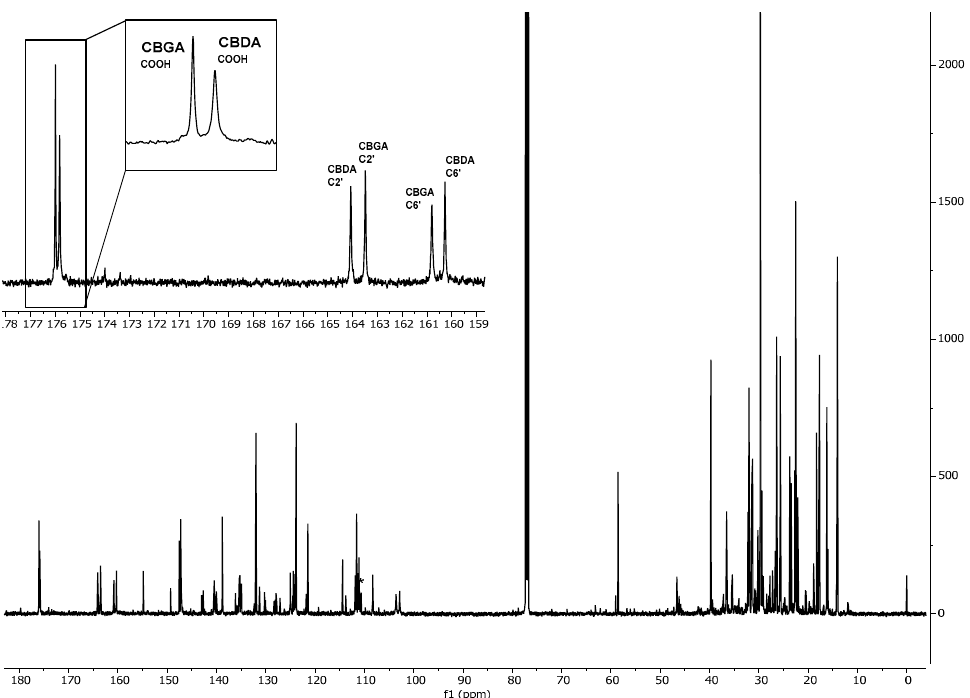
Figure 2. Typical 13 C spectrum of a hemp ethanolic extract; the enlarged region shows the high spectral resolution.